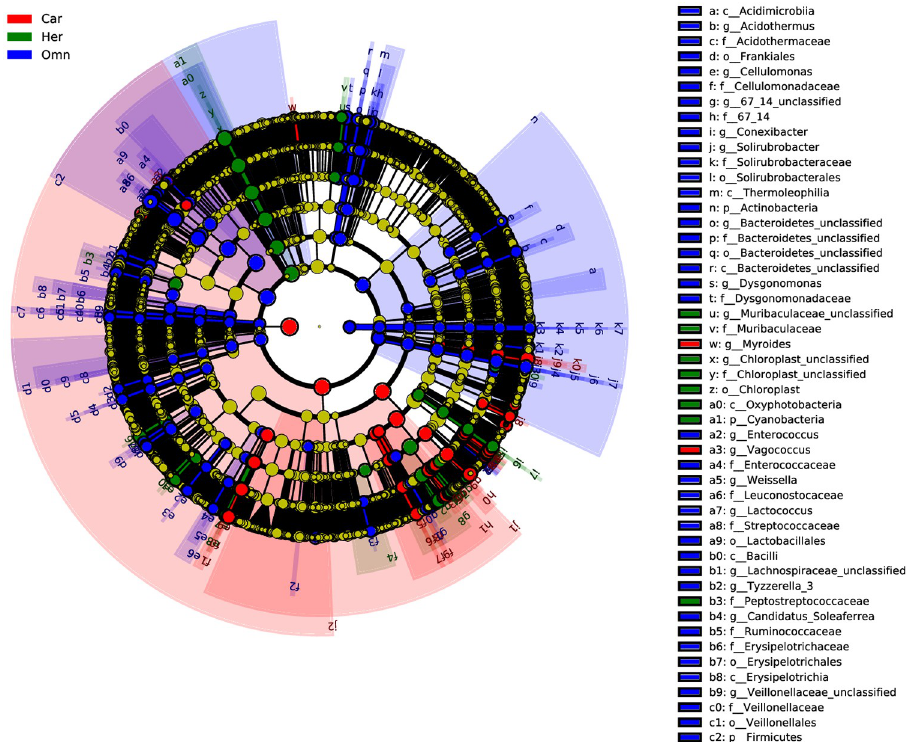
Fig 6. LEfSe analysis: Biomarkers associated with three feeding type. Car: Carnivores; Her: Herbivores; Omn: Omnivores.